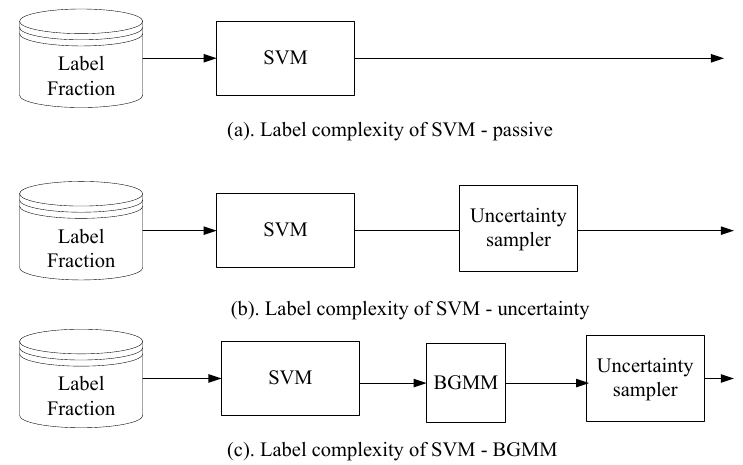
Figure 9. Label complexity of three different settings of the Support Vector Machine classifier. In each setting, the error rate is measured as a function of label